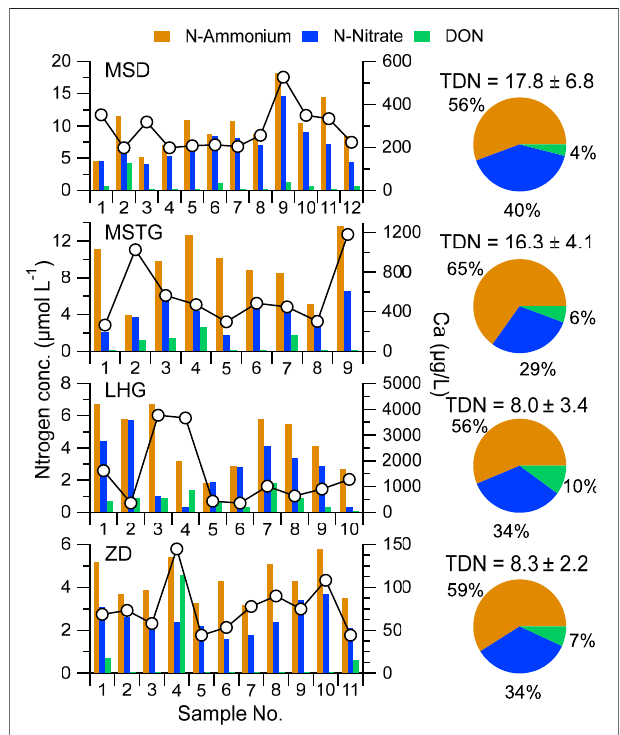
FIGURE 2 | Pro fi les (bar charts) and mean compositions (pie charts) of the nitrogen species (N_Ammonium, N_Nitrate, and dissolved organic nitrogen (DON)) in each snowpit sample. The calcium (Ca 2+ ) concentrations in the snowpit samples are also shown for comparison (as open circles) following the sample number from the surface to the bottom of the snowpit. The average mass concentration of total dissolved nitrogen (TDN) in each snowpit is also shown.